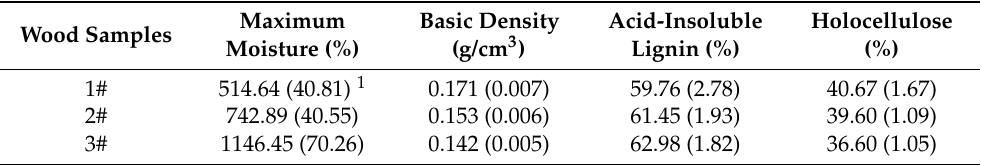
Table 1. Maximum moisture, basic density, acid-insoluble lignin content, and holocellulose content of three wood